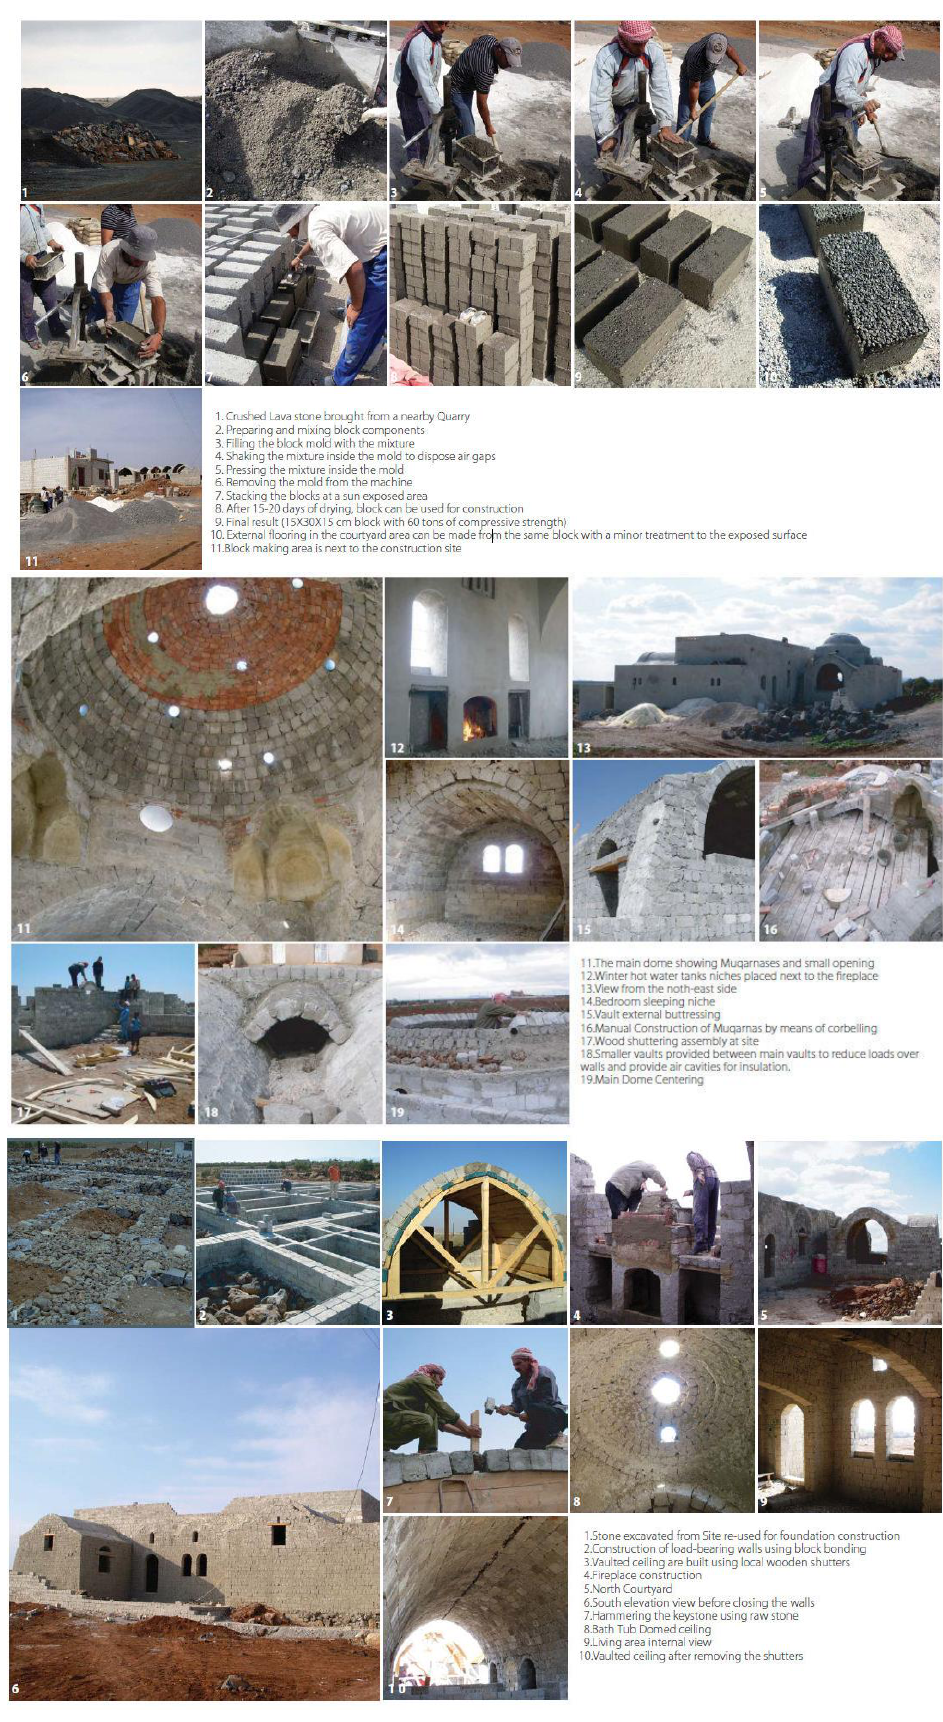
Figure 5. Construction phases (images courtesy of M. Hosam Jiroudy,